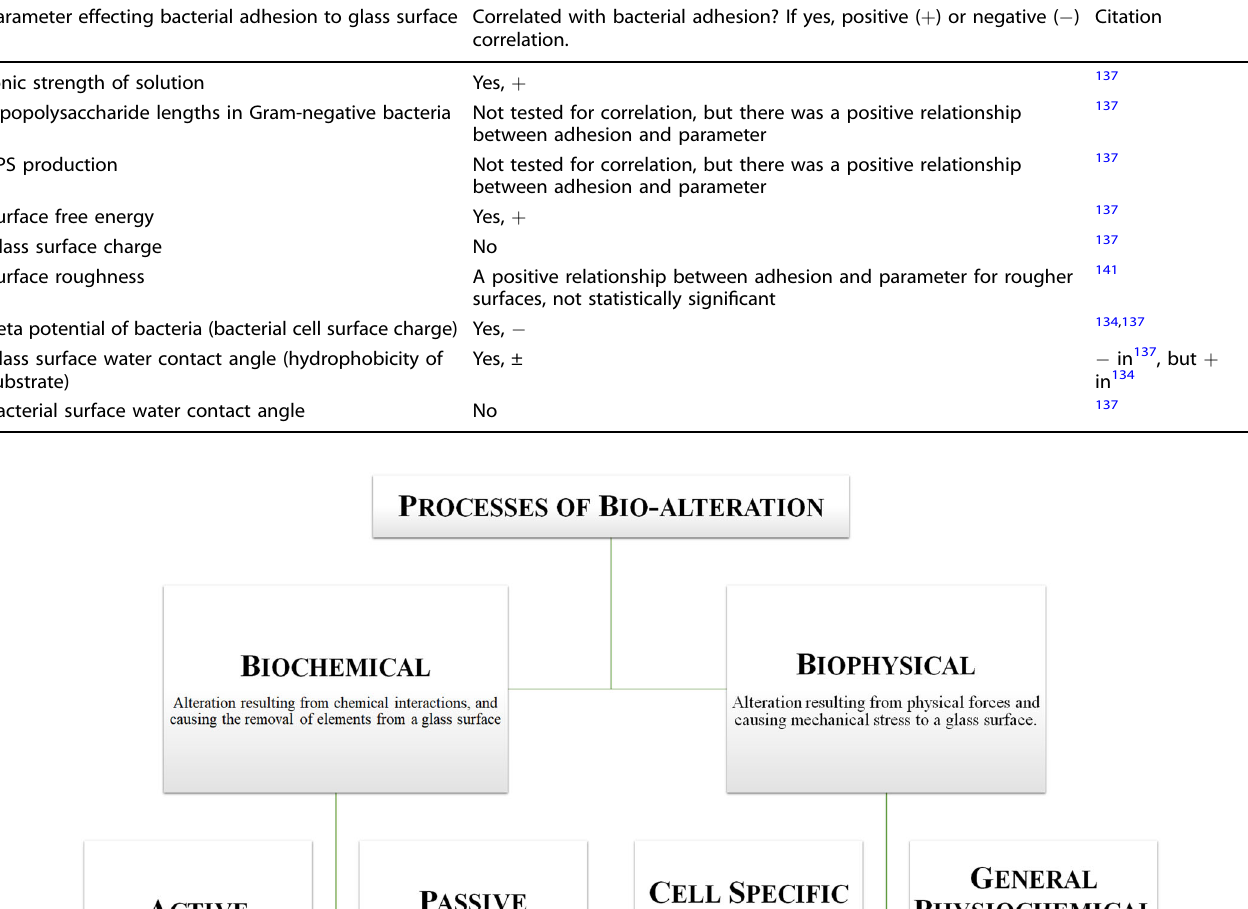
Table 1. Outline of experimentally determined factors that in fl uence bacterial adhesion to glass surfaces. Parameter effecting bacterial adhesion to glass surface Correlated with bacterial adhesion? If yes, positive ( + ) or negative ( − ) correlation.